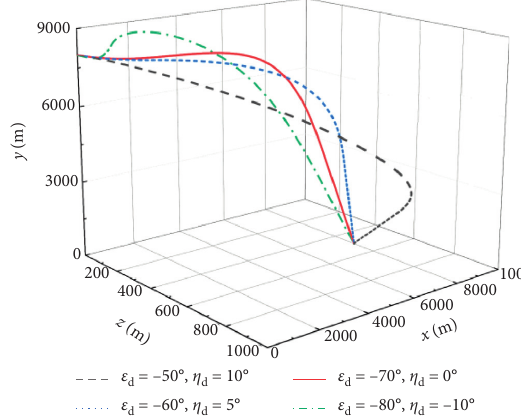
Figure 2: 3D missile and target trajectory curves of Case